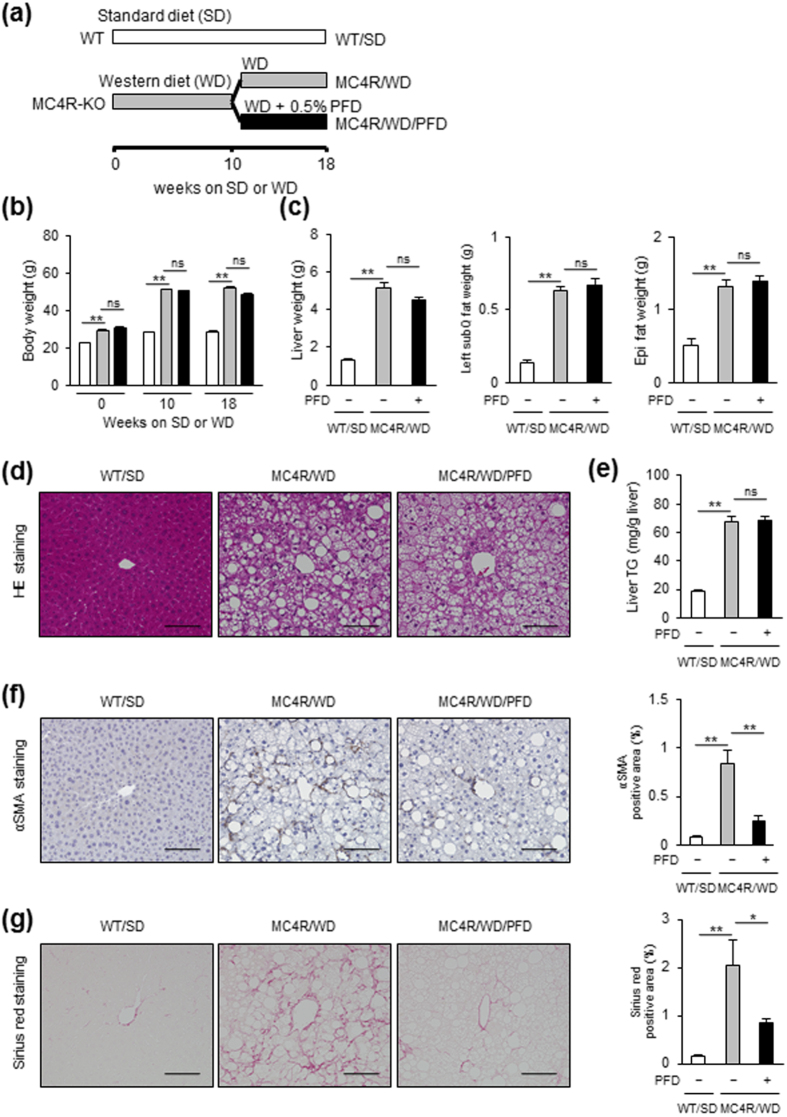
PFD prevents WD-fed MC4R-KO mice from liver fibrosis without affecting steatosis.(a) Study protocol. MC4R-deficient (MC4R-KO) mice were fed a Western diet (WD) for 10 weeks, and then fed a WD with or without PFD for 8 weeks. Control wild-type (WT) mice were fed a standard diet (SD) throughout the experiment period. (b) Body weight, and (c) weights of liver, and subcutaneous (subQ) and epididymal (Epi) fat tissue. (d) Hematoxylin and eosin (HE) staining, and (e) triglyceride (TG) content of the liver. Representative images and quantification of (f) α-SMA immunostaining and (g) Sirius red staining of the liver sections. Original magnification, ×200. Scale bars, 100 μm. *p < 0.05, **p < 0.01; ns, not significant. n = 6–8.